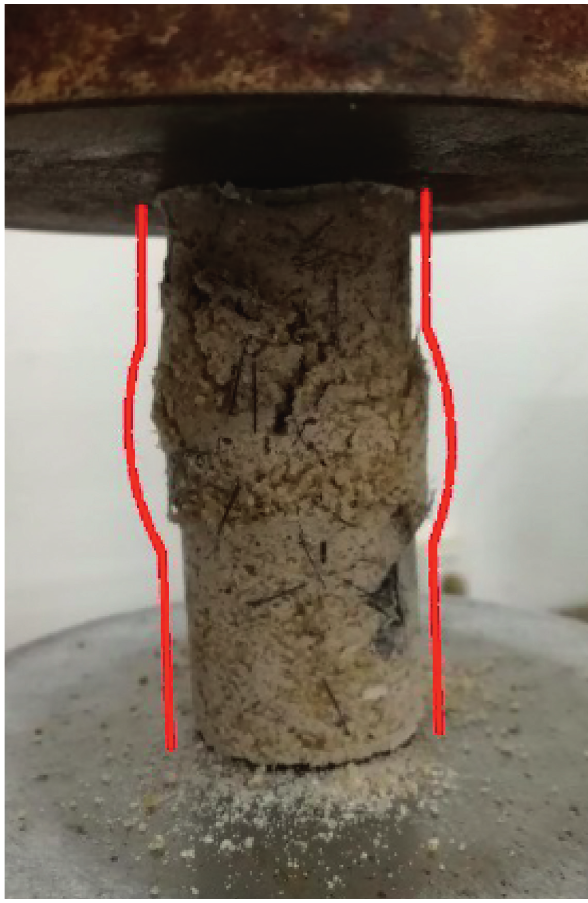
Figure 7: The bulging deformation of the sample reinforced with carbon